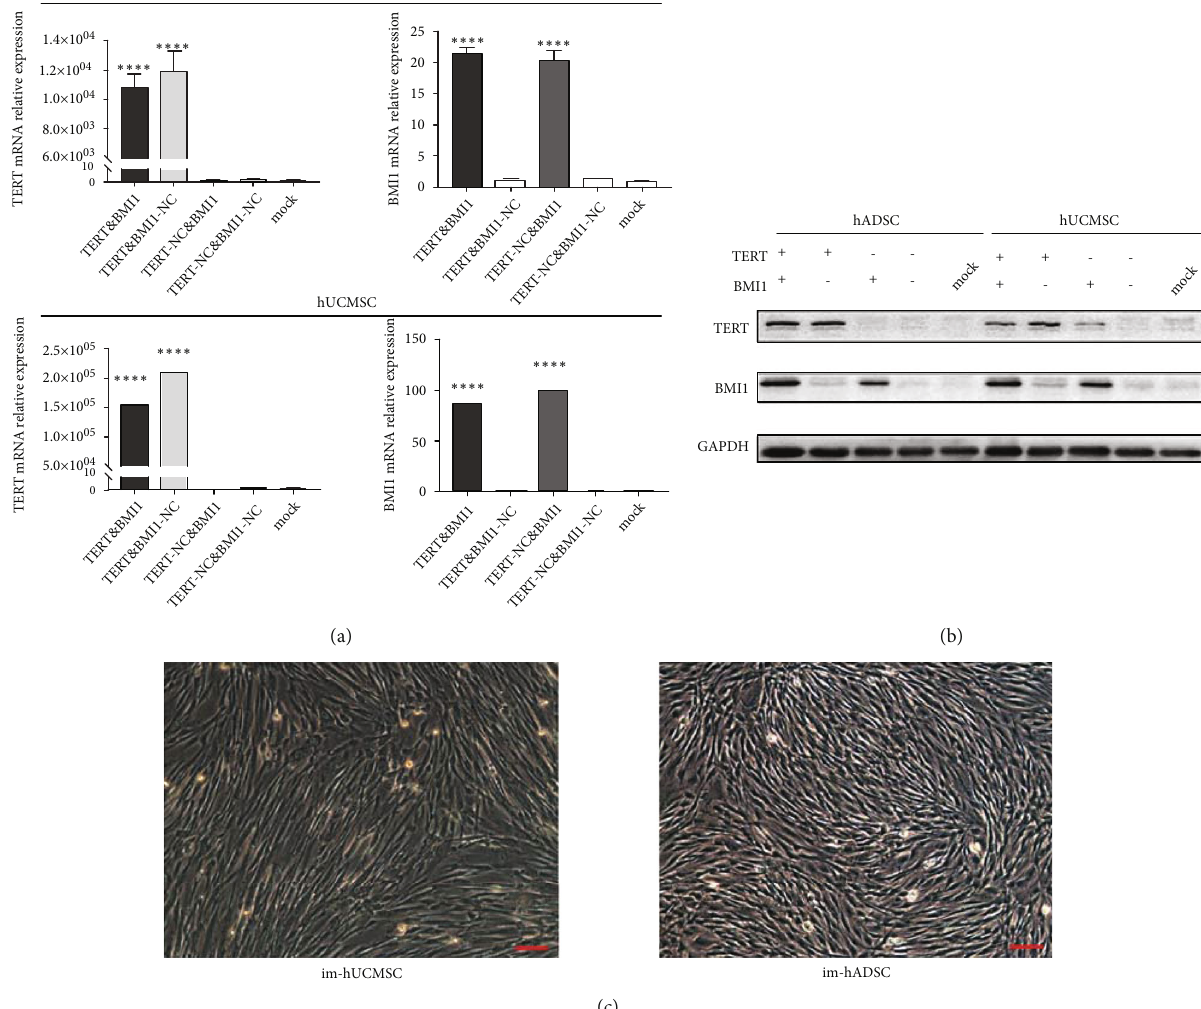
Figure 2: Protein and mRNA expression of BMI1 and TERT genes in immortalized MSCs. (a) RT-PCR analysis of BMI1 and TERT mRNA expression in hADSC and hUCMSC infected with LV-TERT, LV-BMI1, and control lentivirus (mean ± SD, n =3). (b) Western blot detection of TERT and BMI1 protein expression in hADSC and hUCMSC after overexpressing TERT or BMI1. (c) Microscopic view of immortalized hADSC and hUCMSC, respectively, magni fi cation, × 100, scale bar, 100 μ m. The results are presented as the mean ± SD of biological triplicate assays. ∗∗∗ ∗ P < 0 : 0001 . LV: